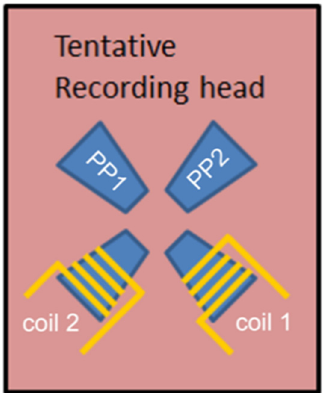
Figure 5. Possible device for recording the magnetic states of an individual T-shaped structure. It